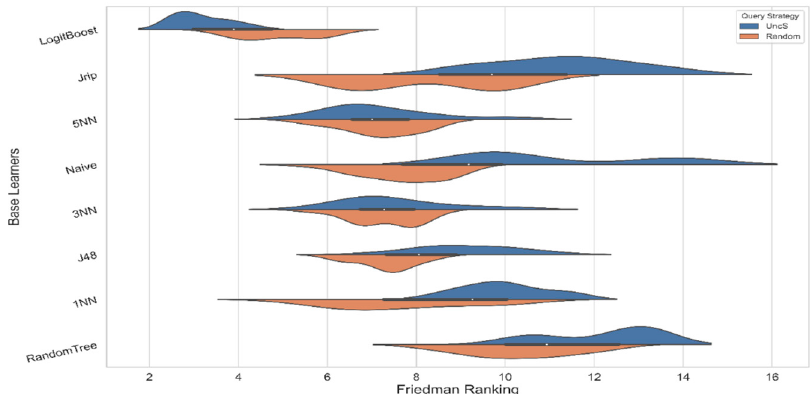
Figure 1. Violin plot presenting the distribution of Friedman rankings for all the examined learners comparing the performance of the selected query strategies against active learning’s baseline, clarifying better the total performance of all the included approaches.